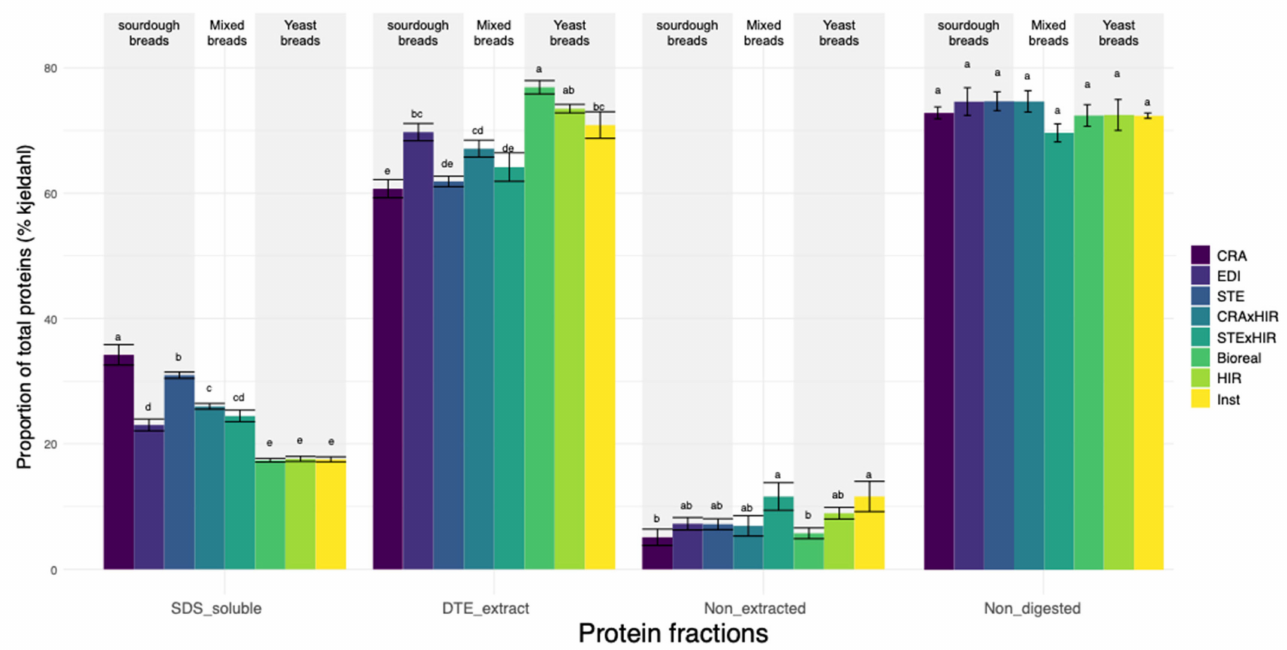
Figure 5. Proportions (out of total protein content—Kjeldahl) of protein fractions (SDS_soluble proteins, DTE-extracted and non-extracted proteins) and in vitro digestibility (Non_digested) of the three sourdough breads (CRA, EDI, STE), the two mixed breads (CRA*HIR, STE*HIR), and the three yeast breads (Bioreal, HIR, Inst). (“CRA”, “EDI”, and “STE” refer, respectively, to the bakers Collectif Cravirolla, Edith Brissiaud, and St é phane Marrou, and “HIR”, “Bioreal”, and “Inst”